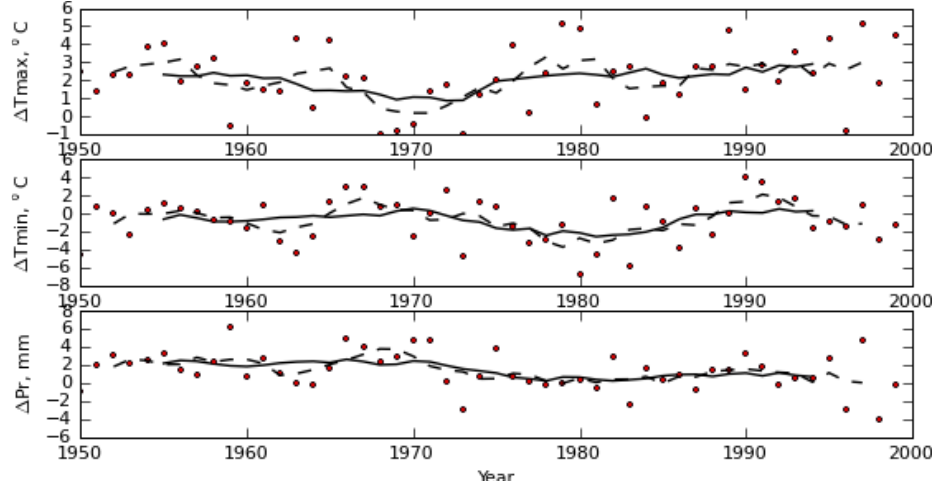
Fig. 7. Biases in seasonal statistics of daily Tmax, Tmin, and Pr based on the GFDL model from 1950–1999 at grid cell 2 (see Fig. 1). Points are biases in the median for the seasonal statistic for each year, dashed line is a 5yr running mean, and the solid line is an 11yr mean.